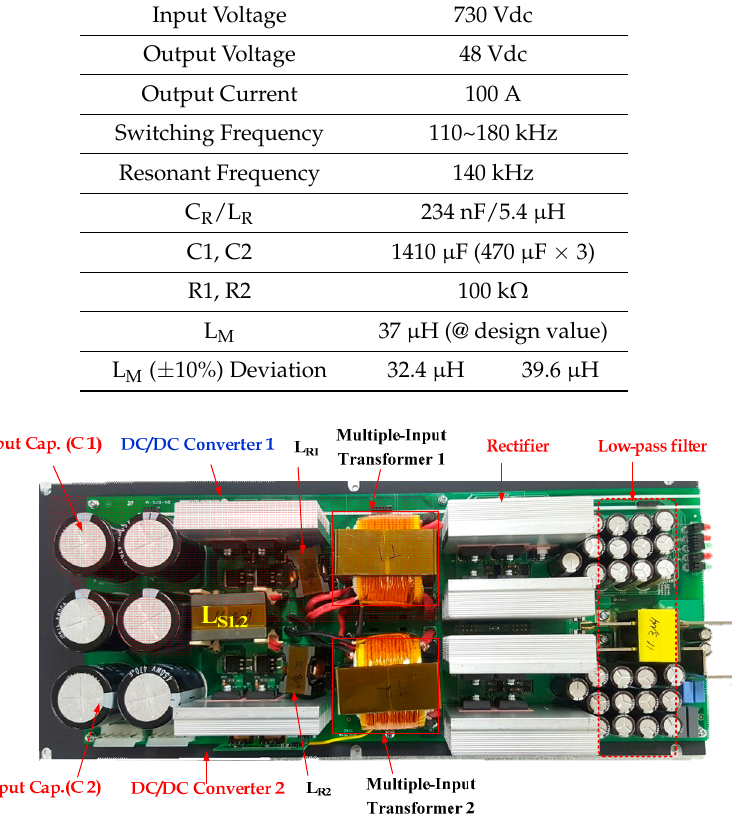
Figure 18. Prototype of the proposed DC/DC Converter.